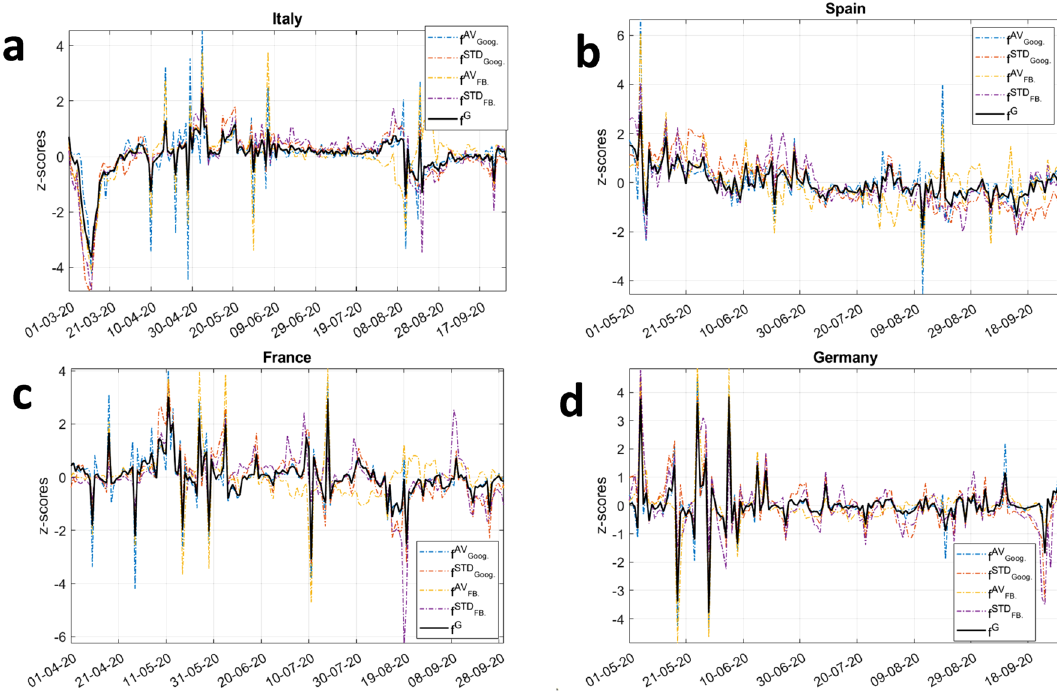
Figure 6. Line diagrams of factor components dynamics. The line diagrams report the in-sample estimates of the global common factor component ( f G ), in black, along with the evolution of the factor components related to the average Google mobility trends ( f AV GOOG ), to the Google mobility trends standard deviation ( f STD GOOG ), to the average Facebook commuting trends ( f AV FB ) and to its standard deviation ( f STD FB ). Moreover, panel ( a